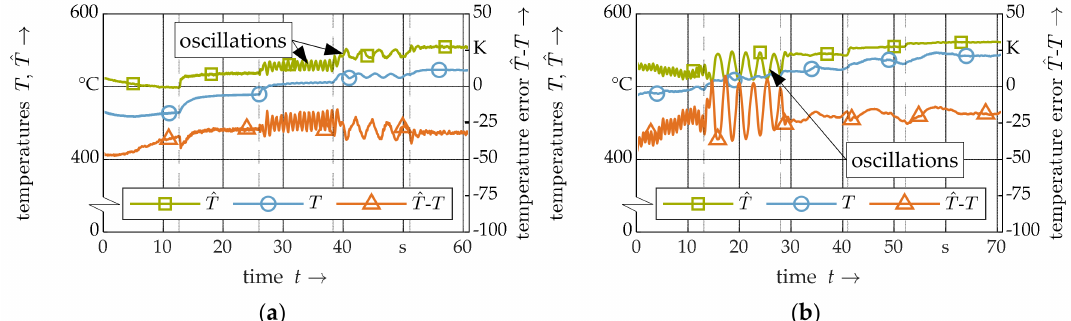
Figure 4. Validation of the digital twin: comparison of the measured temperature T (blue circle) and calculated temperature ˆ T (green square) with the temperature model error ˆ T - T (orange triangle) for ( a ) exp. no. 2 (an enlarged cutout is shown in Figure A4) and ( b ) exp. no. 6; the corresponding welding parameters are given in Table